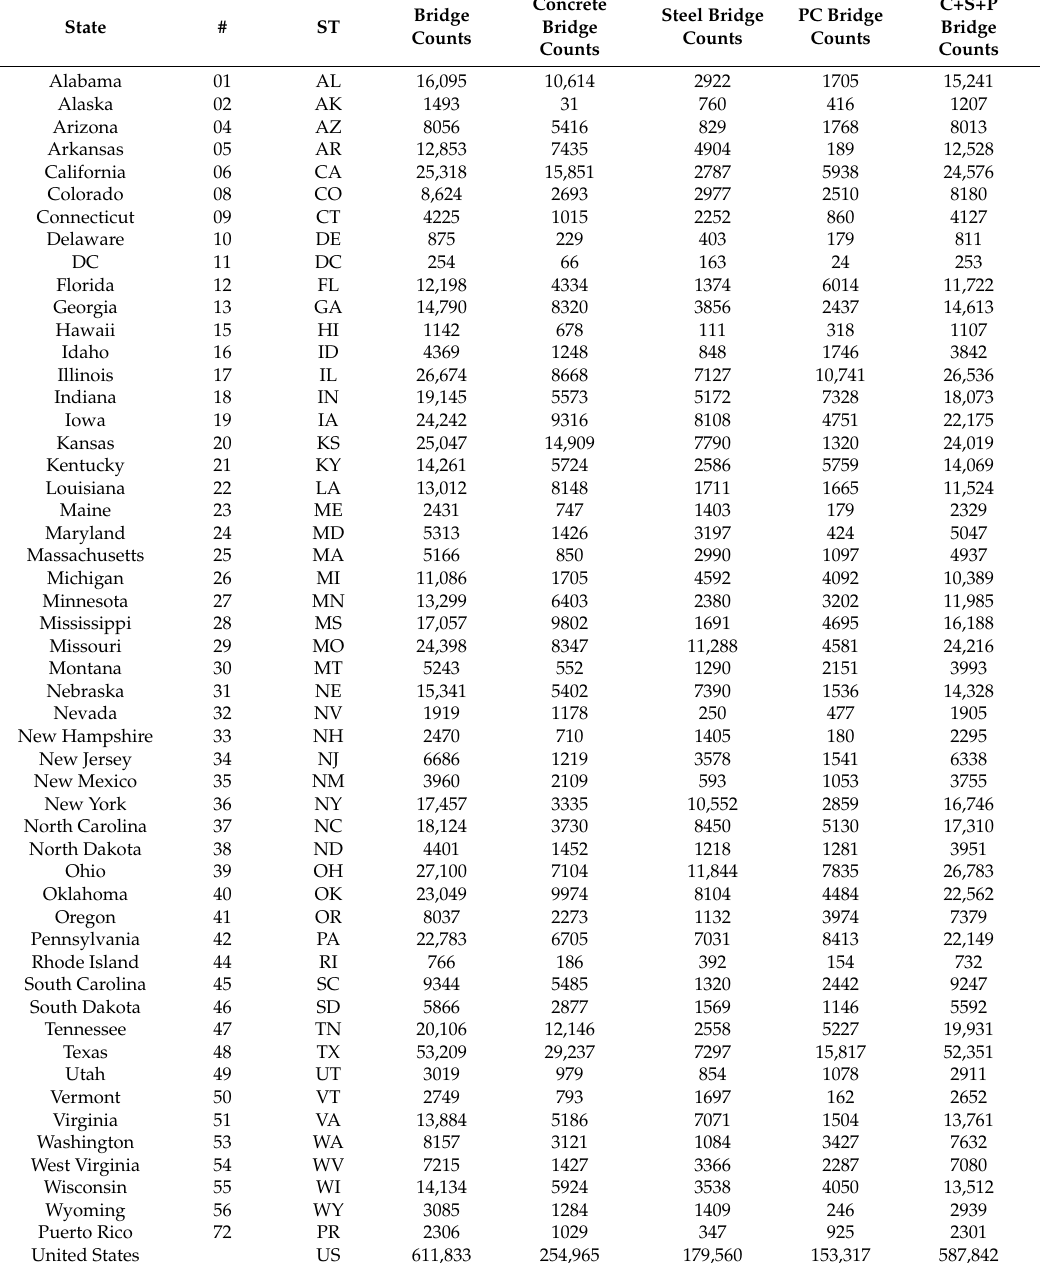
Table 1. Bridge Materials by